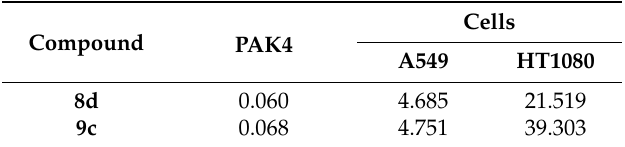
Table 2. IC 50 a ( µ M) of potent compounds on cell